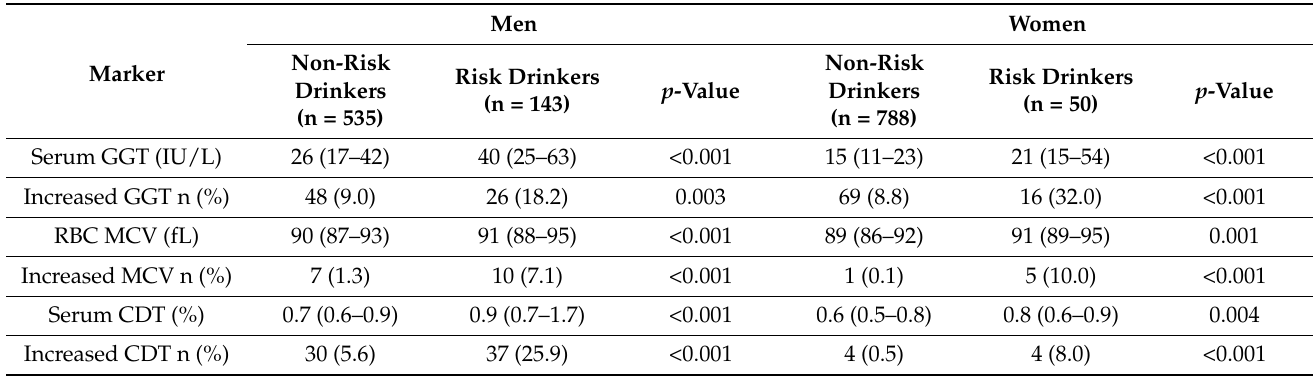
Table 2. Comparison of commercial markers between risk drinkers and non-risk drinkers, stratified by sex.